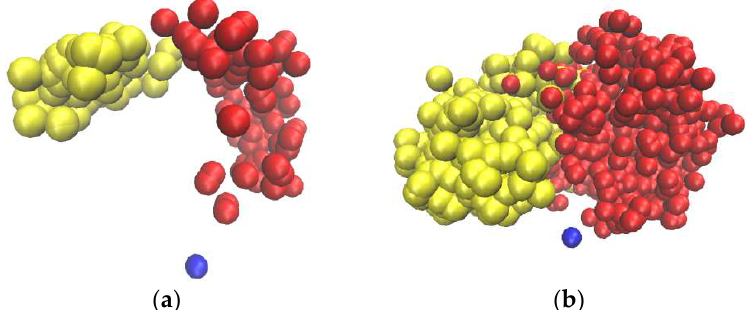
Figure 3. The positions (every 10 ps) of two Si terminal atoms (colored in yellow and red) of the G7 l-dendrimer, during 1 ns ( a ) and 10 ns ( b ). The central atom of the dendrimer is painted blue.